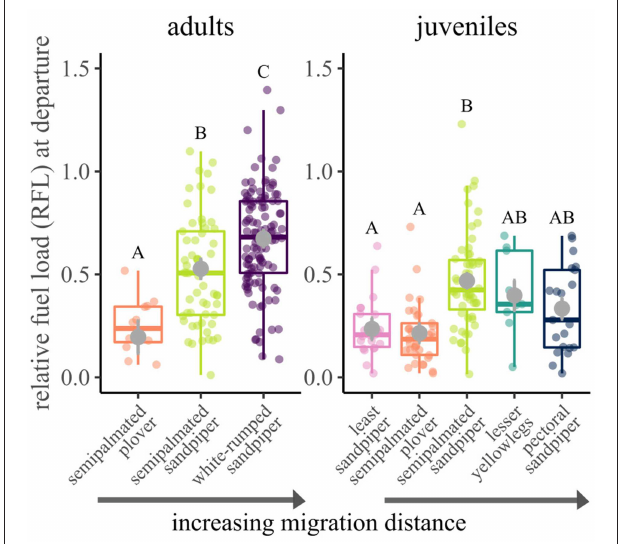
FIGURE 3 | Relative fuel loads of shorebirds departing on migration from the southwestern coast of James Bay, Ontario, Canada in 2014–2017. Each colored point is a measurement of an individual bird, and model estimated mean and standard error are plotted with gray circles and error bars. Different letters designate significant differences ( α = 0.05) for that age